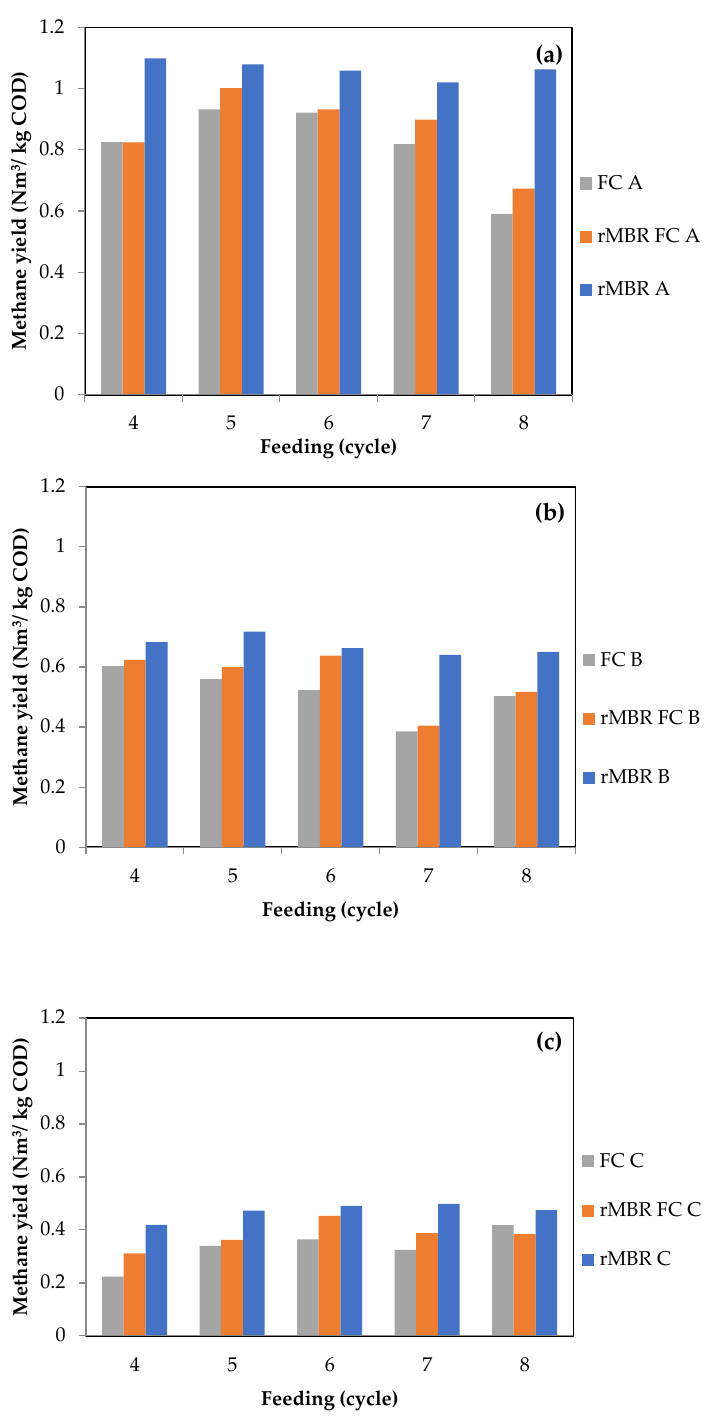
Figure 3. Methane yield after a start-up period for OLRs: ( a ) 0.6; ( b ) 1.2; ( c ) 3.6 g VS/(L cycle).